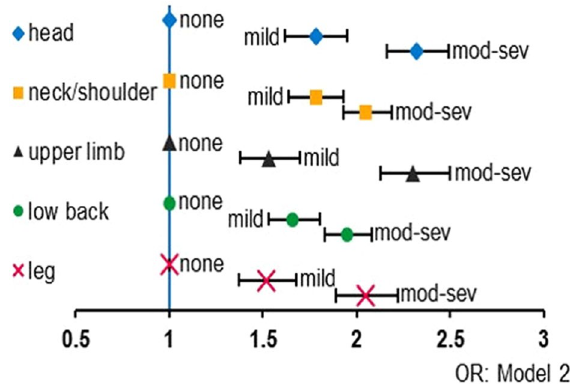
Figure 1. Degree of loneliness and pain symptoms since before the COVID-19 outbreak. Odds ratios of each pain symptom in model 2 by the degree of loneliness compared to none of the loneliness were indicated. X-axis indicated odds ratio. Bars indicated 95% confidence intervals. Abbreviation: mod‑sev moderate-to-severe, OR odds ratio.